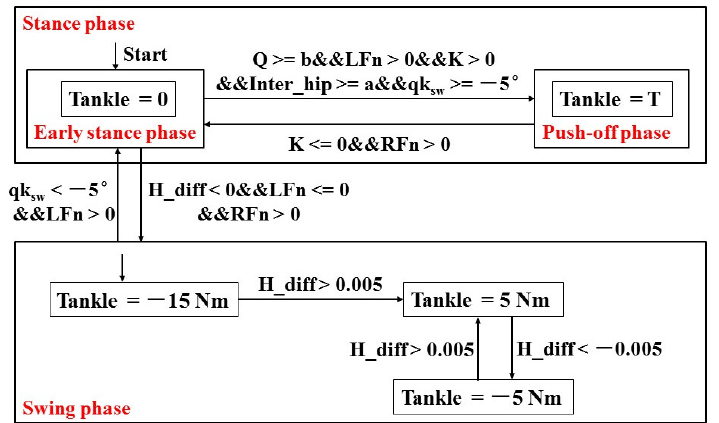
Figure 5. State machine of ankle torque. Tankle indicates ankle torque, and T indicates the ankle torque during the push-off phase. LFn and RFn represent ground reaction forces. Inter_hip denotes the angle between the two legs. H_diff is defined by the difference between the toe and the heel of the swing leg.